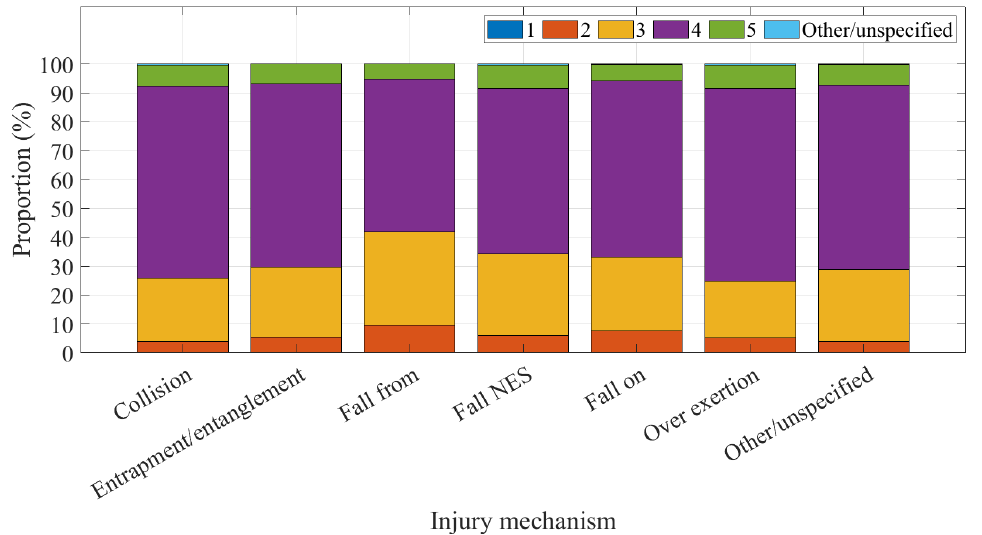
Figure 9. Injury severity by